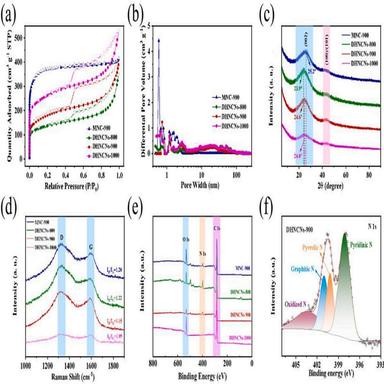
The nitrogen adsorption/desorption isotherms of the MNC-900 and DHNCNs-T (a), and the pore size distributions of the MNC-900 and DHNCNs-T (b), XRD patterns of the MNC-900 and DHNCNs-T (c), Raman spectra of the MNC-900 and DHNCNs-T (d), XPS spectra of the MNC-900 and DHNCNs-T (e), and high-resolution spectra of N 1s for the DHNCNs-900 (f).